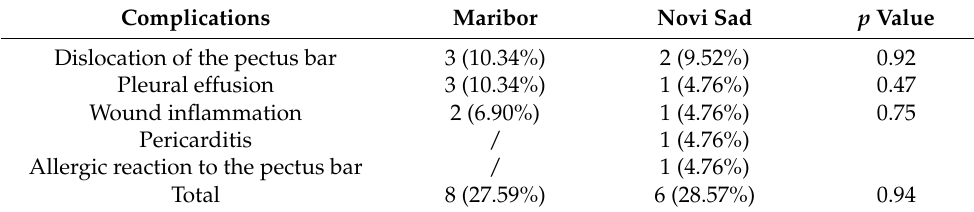
Figure 3. A girl with a pectus excavatum deformity before the surgery and after the standard Nuss procedure. Table 3. Frequency and structure of complications in Maribor and Novi